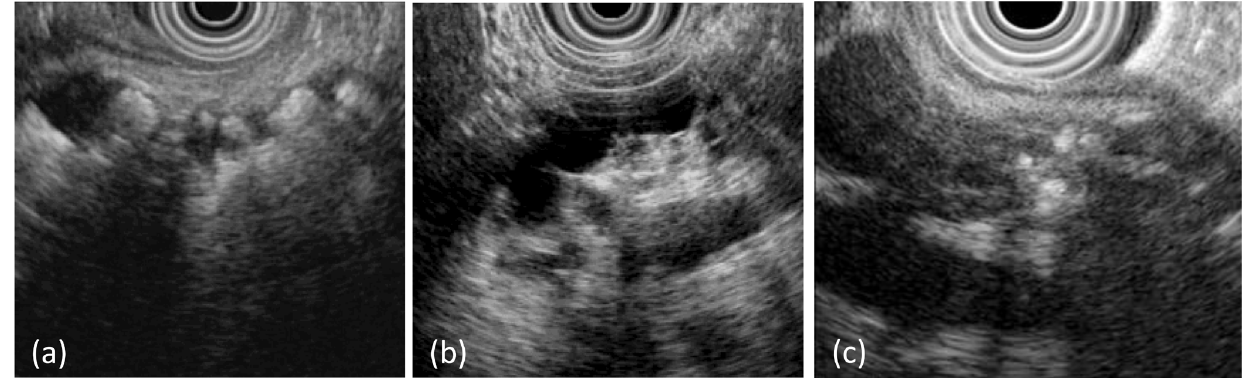
Figure 2. Endoscopic ultrasound images characterizing features of chronic pancreatitis. ( a ) Anechoic tubular structure with multiple hyperechoic structures with shadowing. Depicts a dilated main pancreatic duct with multiple calcified stones. ( b ) Anechoic tubular structure depicting dilated, irregular main pancreatic duct. ( c ) Diffuse echogenicity with hyperechoic foci with stranding. Depicts pancreatic lobularity with calcifications.